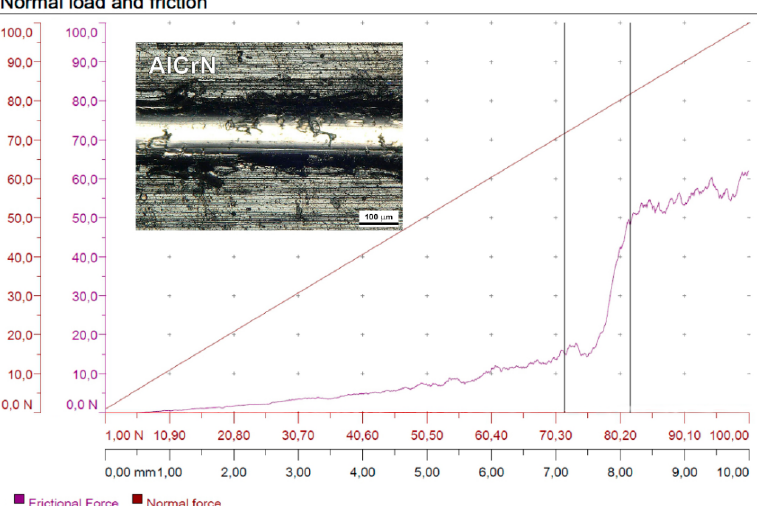
Figure 5. Scratch test results of the X40CrMoV5-1 tool steel sample with AlCrN coating.